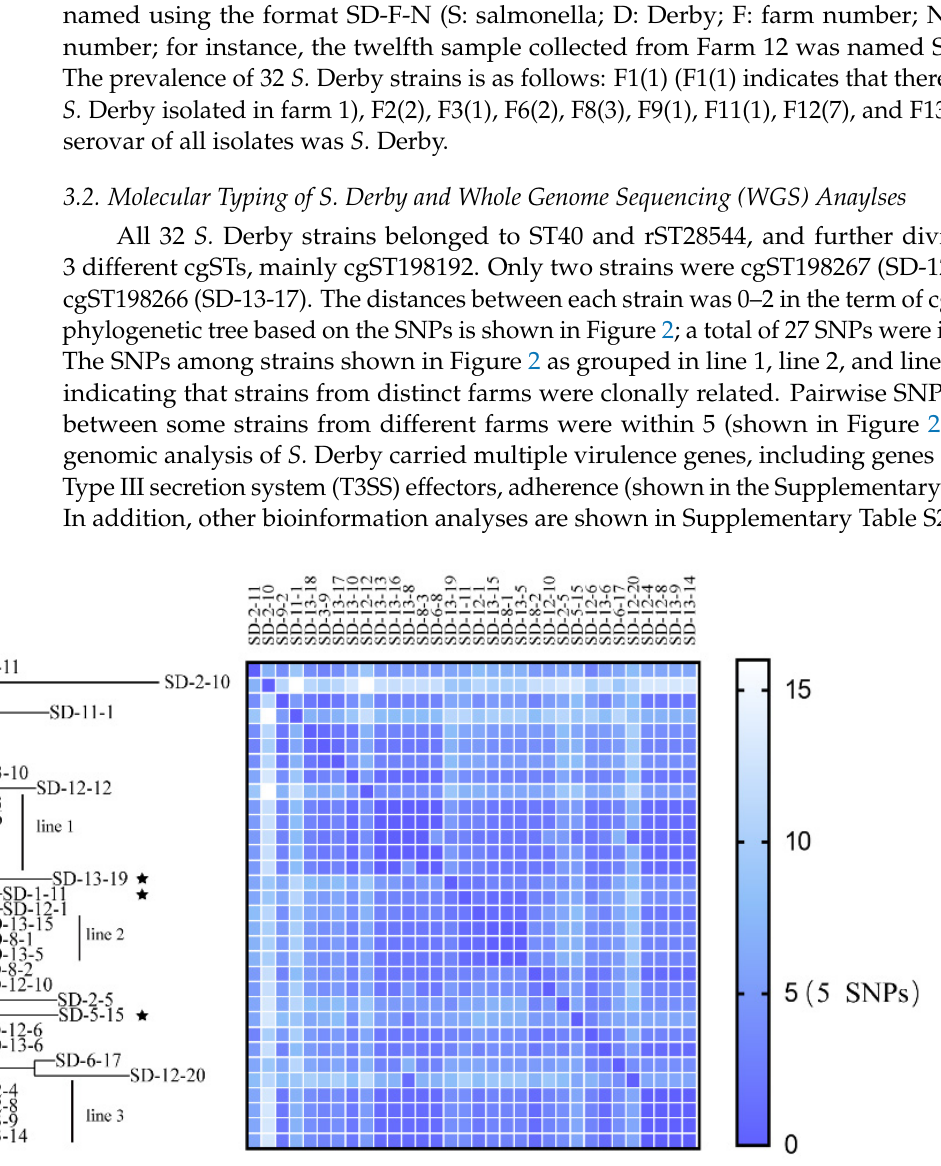
sequences. All positions containing gaps and missing data were eliminated. There was a total of 27 positions in the final